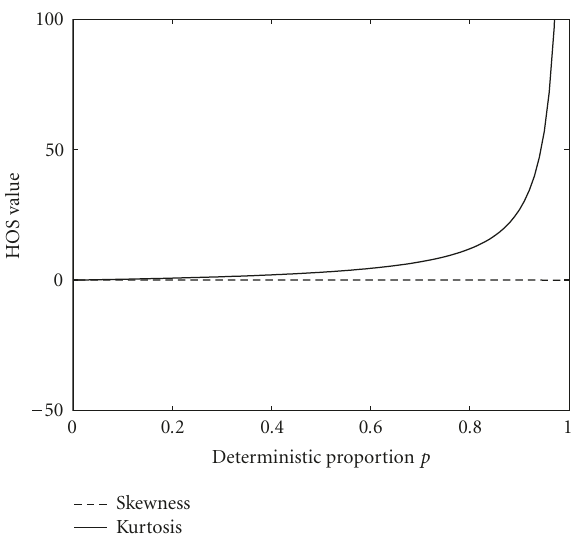
Figure 4: Skewness (dashed line) and kurtosis (solid line) in func- tion of parameter p for SNR = − 60 dB.